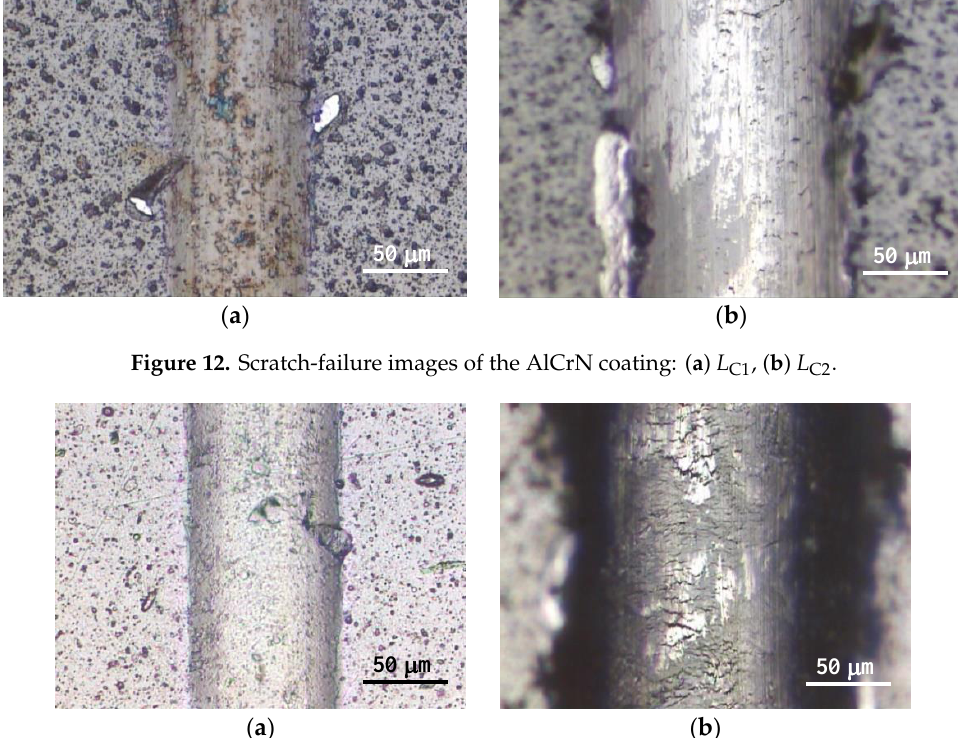
Figure 13. Scratch-failure images of the AlCrN + CrCN coating: ( a ) L C1 , ( b ) L C2 .